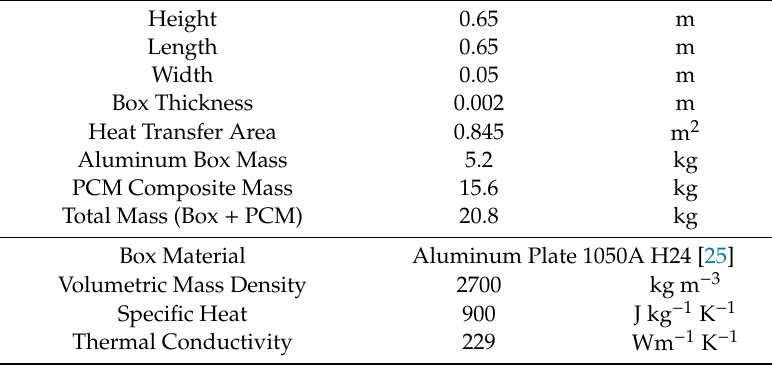
Table 2. Key physical characteristics of the device, considering the casing and the phase change material (PCM) composite.